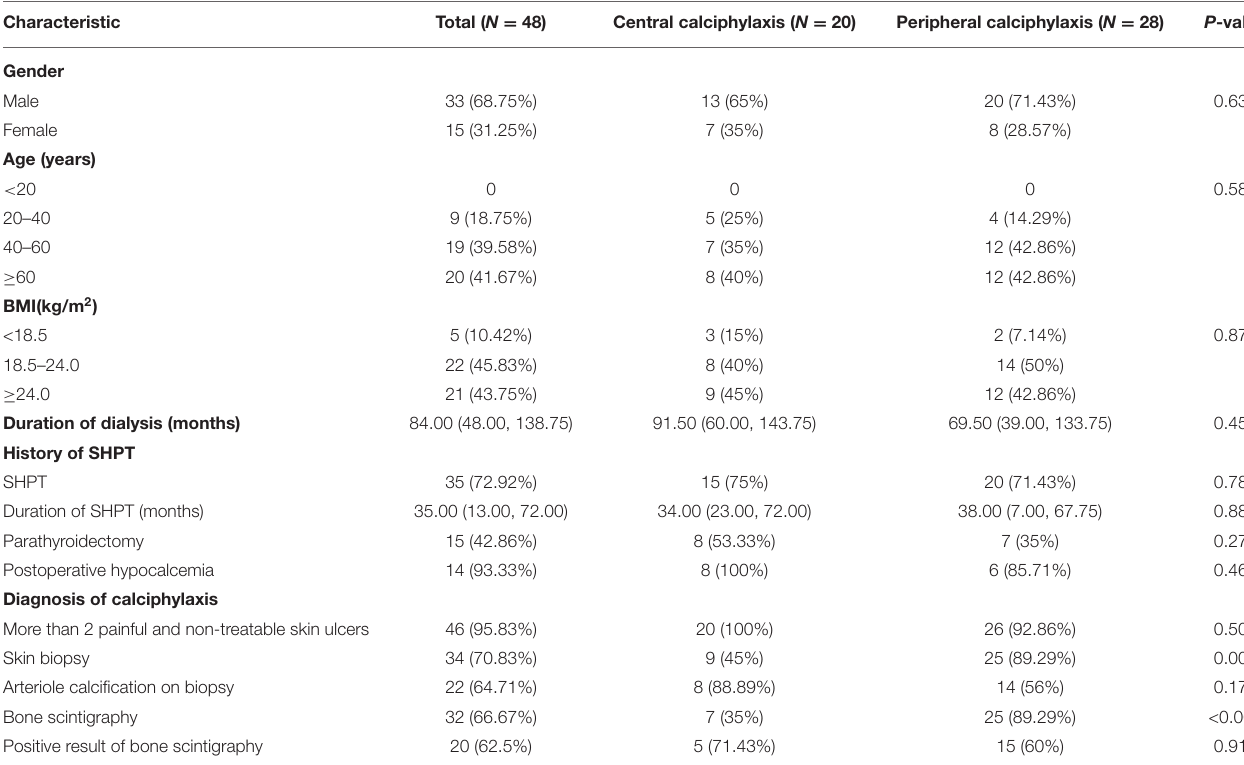
TABLE 2 | Comparison of characteristics between central and peripheral calciphylaxis